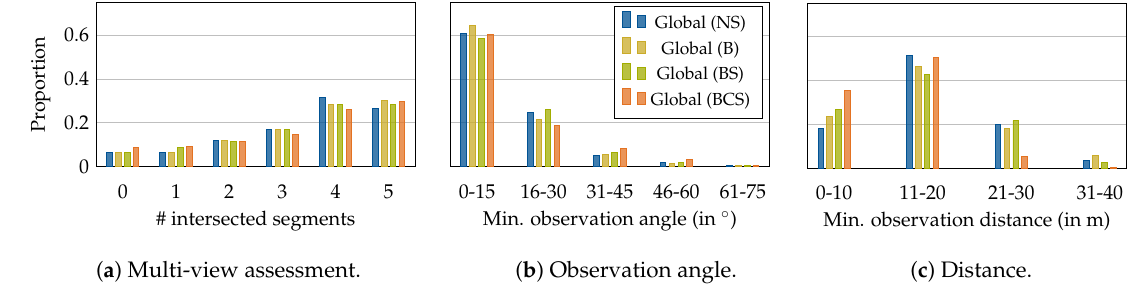
Figure 10. Evaluation of heuristics for optimized semantically-aware trajectories per surface point s . Number of intersected surface hemispheres ( a ), minimum observed observation angles ( b ) and minimum observation distance ( c